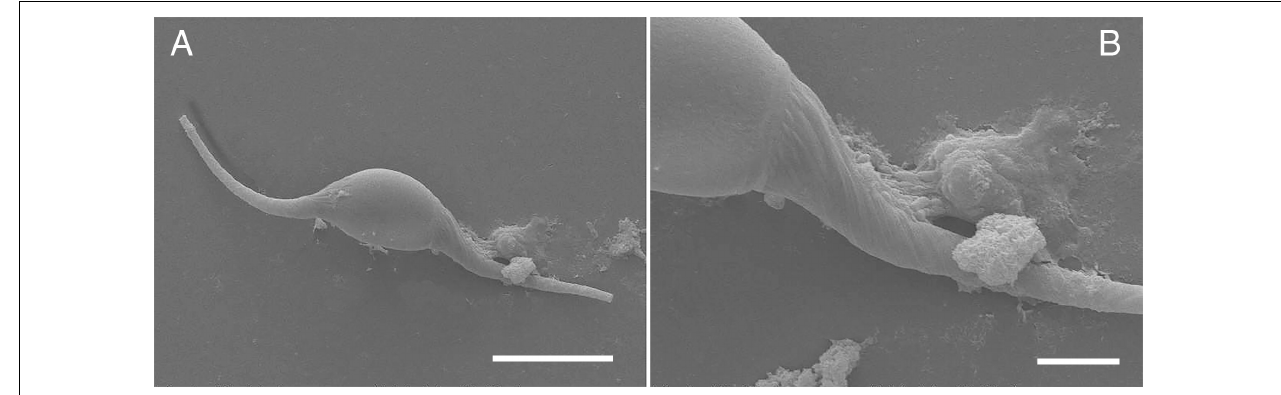
FIGURE 5 | Scanning electron microscopic images of eggs of Ogmogaster heptalineatus . (A) Overview of closed egg exhibiting filaments on both egg poles, (B) detailed view of emanating filament composed of various intertwined wisps. Scale bars: (A) 20 µ m, (B) 5 µ